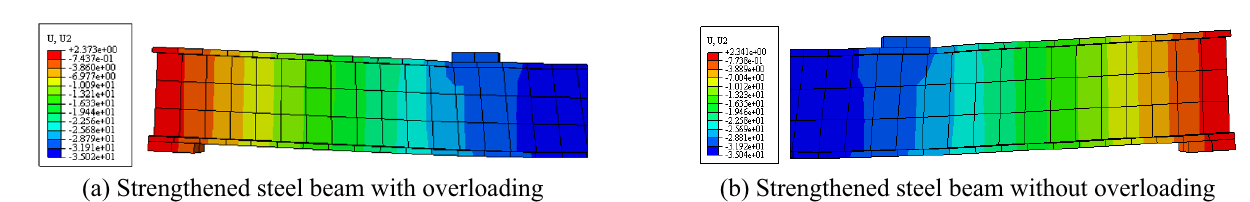
Figure 16. Deflection comparison of steel beam with or without